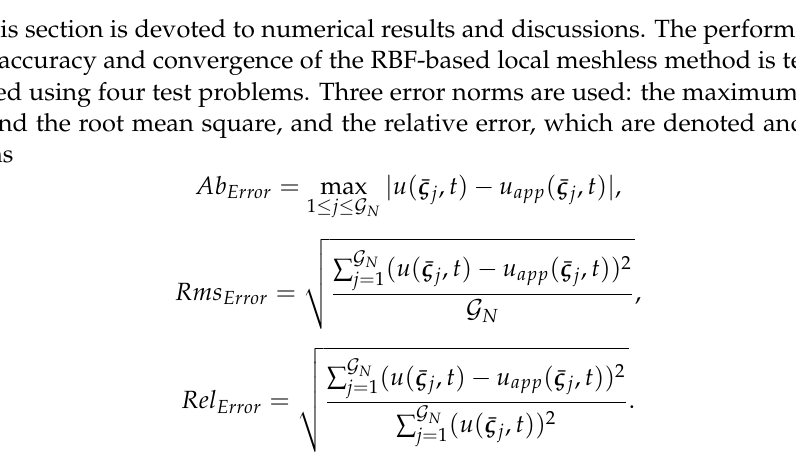
Figure 2: The plot show the stability constant η of the differentiation matrix Figure 2. The plot shows the stability constant η of the differentiation matrix 2 (c) problem 4 ( b ) problem 2; ( c ) problem